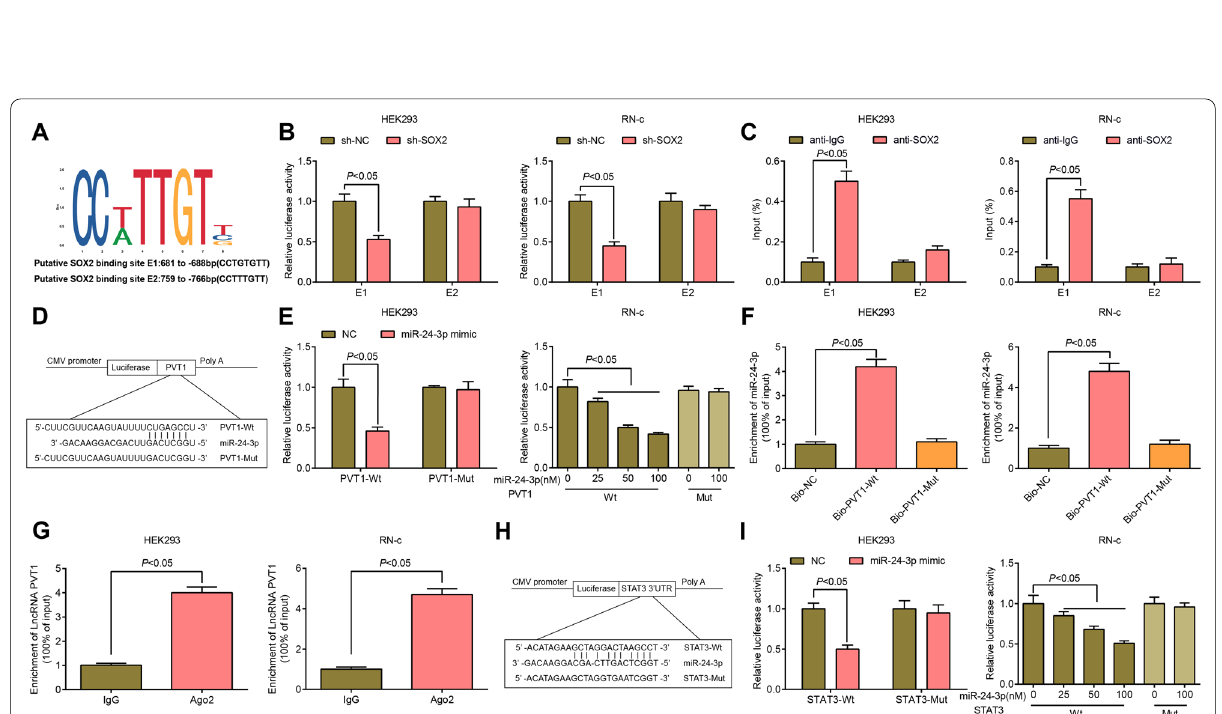
Fig. 7 SOX2 regulates STAT3 expression via activating PVT1 to sponge miR-24-3p. A Bioinformatics website prediction of the binding site of SOX2 and PVT1 promoter; B Dual luciferase reporter gene assay of validation of the binding relationship between SOX2 and PVT1 in HEK293 cells and RN-c cells; C ChIP-qPCR assays of validation of the binding relationship between SOX2 and PVT1 in HEK293 cells and RN-c cells; D The surmised binding sites for interaction between PVT1 and miR-24-3p; E Dual luciferase reporter gene assay of verification of the binding of PVT1 and miR-24-3p in HEK293 cells and RN-c cells; F RNA-pull down assay of verification of the binding relationship between PVT1 and miR-24-3p in HEK293 cells and RN-c cells; G RIP assay of verification of the binding relationship between PVT1 and miR-24-3p in HEK293 cells and RN-c cells; H The surmised binding sites for correlation between miR-24-3p and STAT3; I Dual luciferase reporter gene assay of validation of the targeting relationship between miR-24-3p and STAT3 in HEK293 cells and RN-c cells; Repetition =